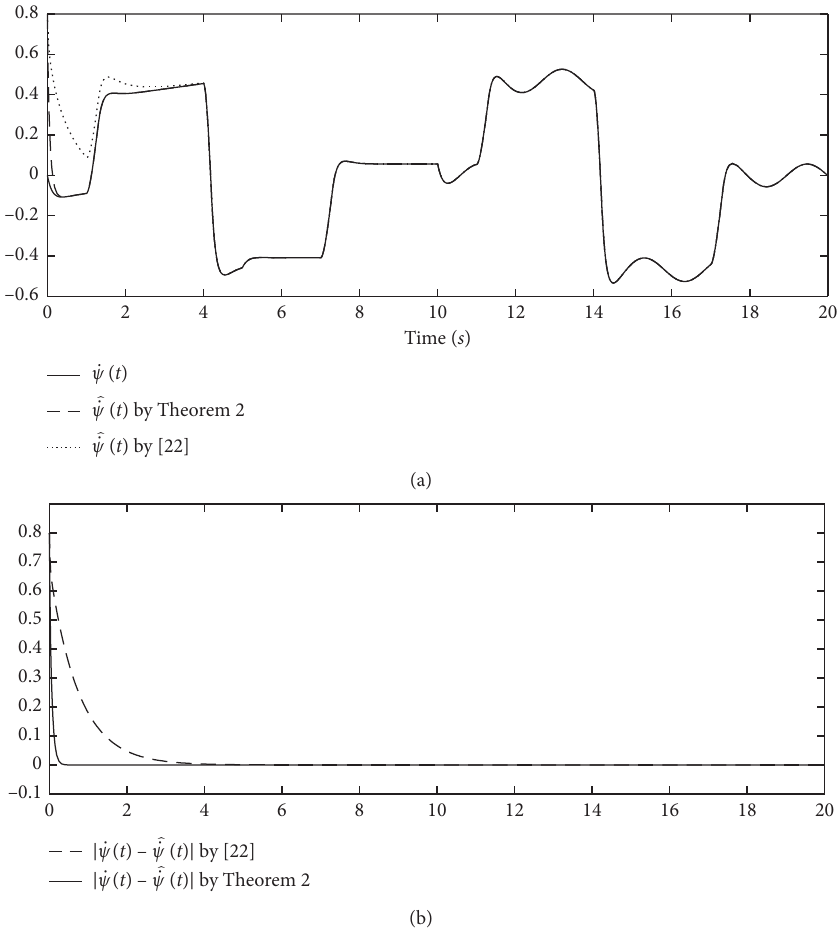
Figure 5: (a) Time evolution of the yaw rate and its estimates. (b) Error estimation of the yaw rate.